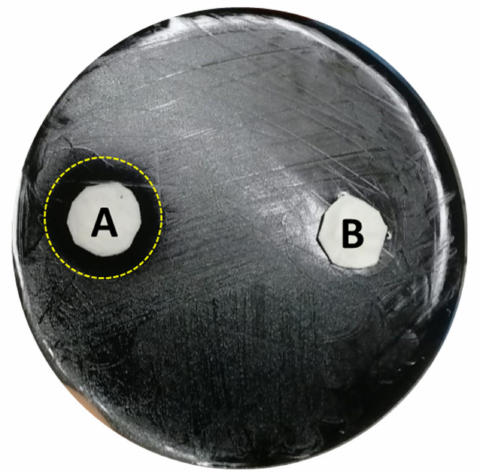
Figure 2. Modified Zone of Inhibition Test of Legionella pneumophila 2-14 after 24 h incubation with s-PBC@PP (A) and reference PP (B) coupons after 0.2 mL spotting of water. The yellow dot ring evidences the 2 cm Ø clear